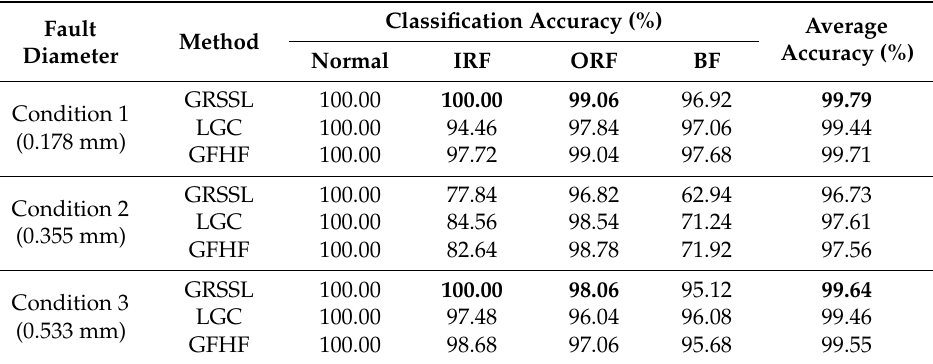
Table 3. Results of LGC, GFHF, and GRSSL under different severity of fault with the imbalance ratio r = 16 (IRF–inner race fault, ORF-outer race fault, BF-ball